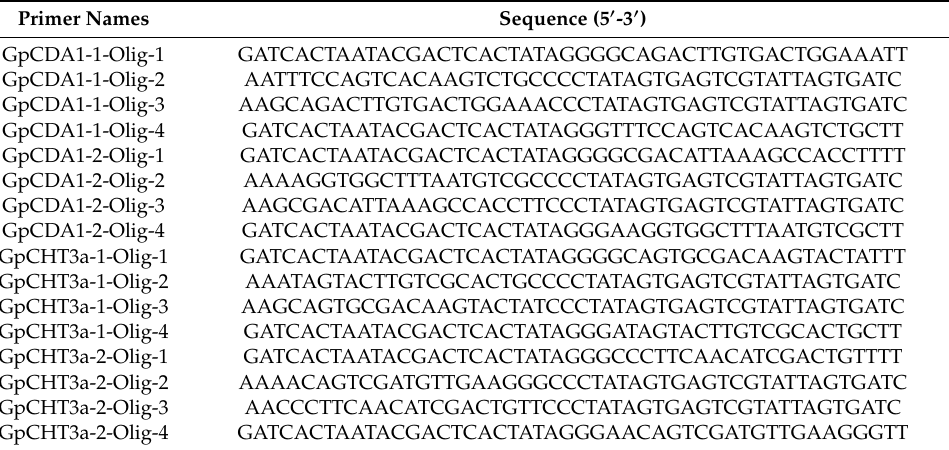
Table 5. Primers used to synthesize